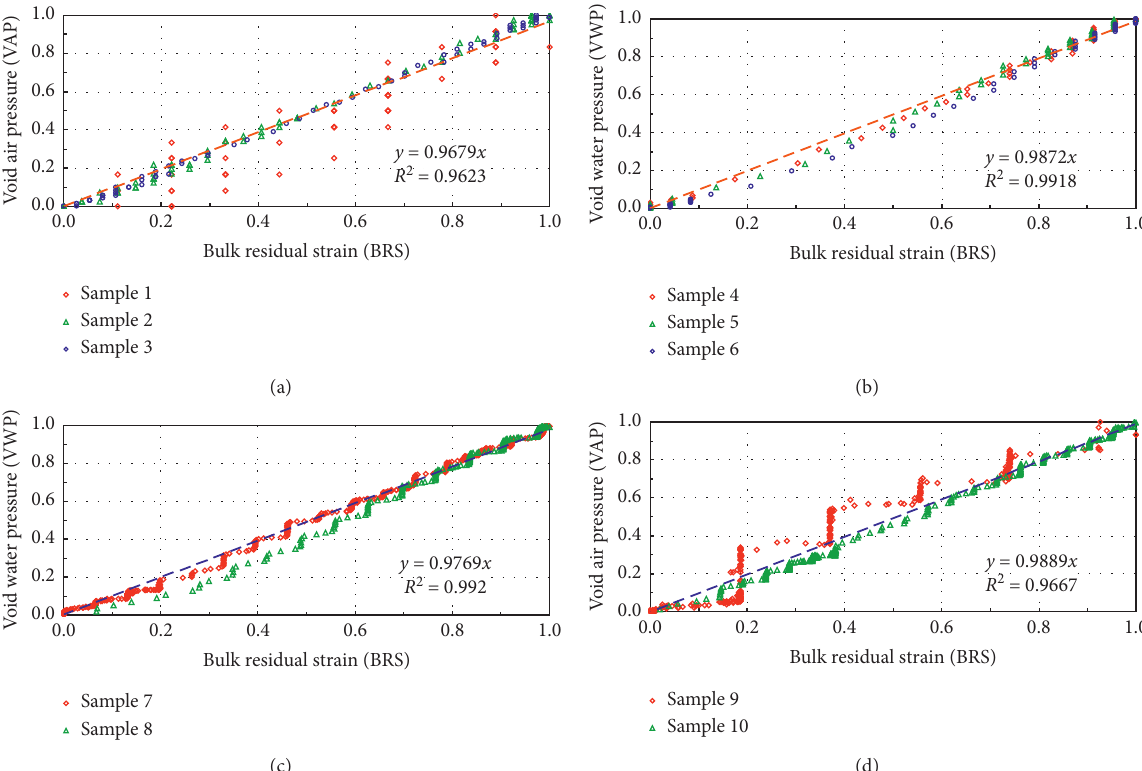
Figure 10: Relationship between bulk residual strain and void pressure (the same normalized method as shown in Figure 2). (a) Samples 1–3 (US). (b) Samples 4–6 (SS). (c) Samples 7-8 (SD). (d) Samples 9-10